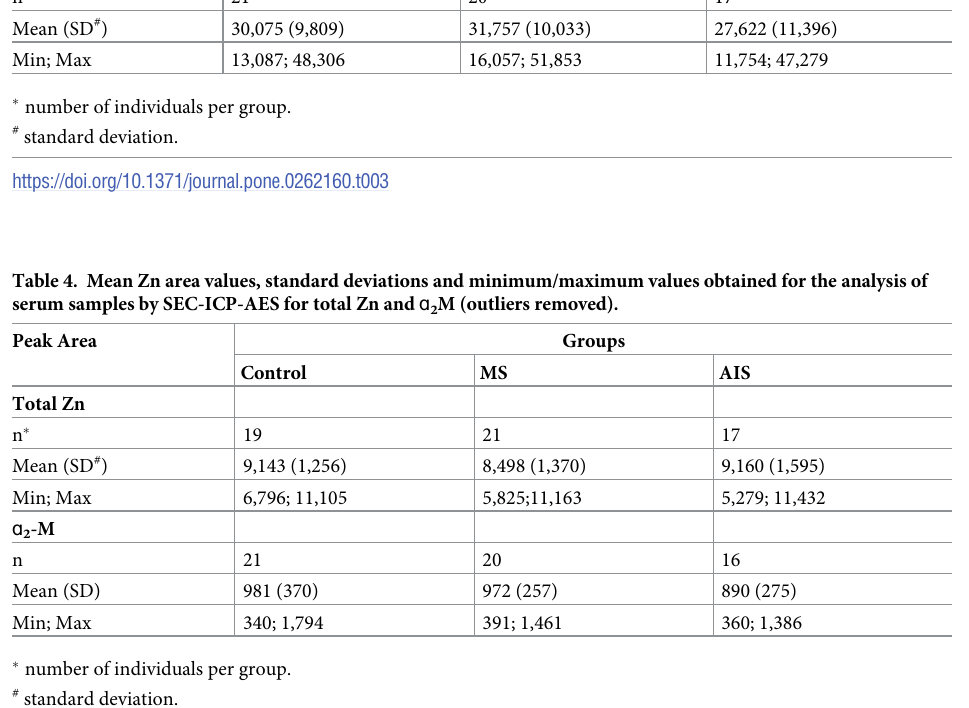
Table 3. Mean Cu area values, standard deviations and minimum/maximum values obtained for the analysis of serum samples by SEC-ICP-AES (outliers removed). Peak Area Groups Control MS AIS Total Cu n � 21 20 17 Mean (SD # )